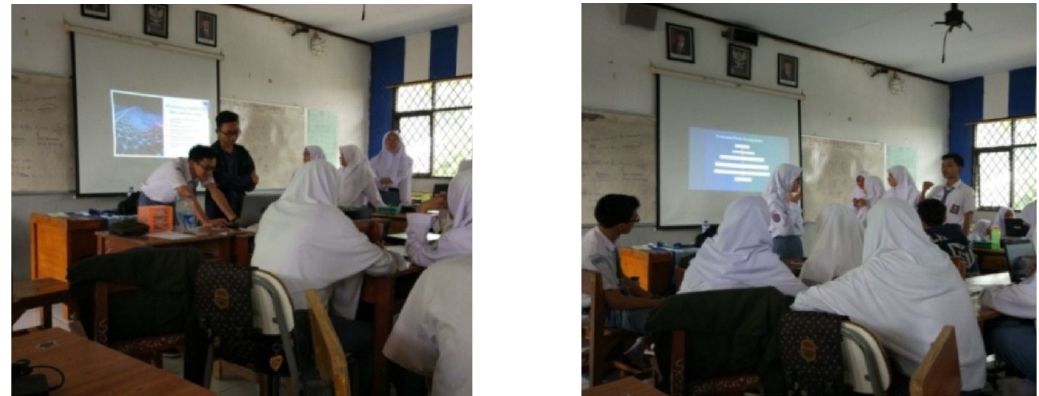
Figure 5. Students presenting their plans for making biodegradable